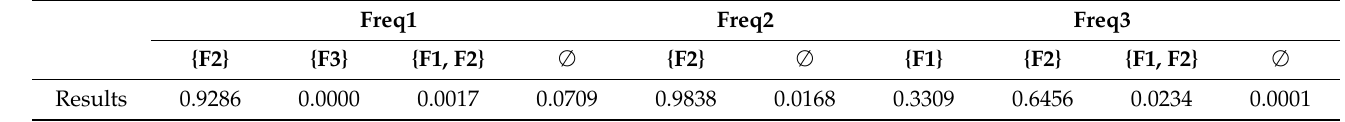
Table 11. Data fusion results for fault diagnosis.